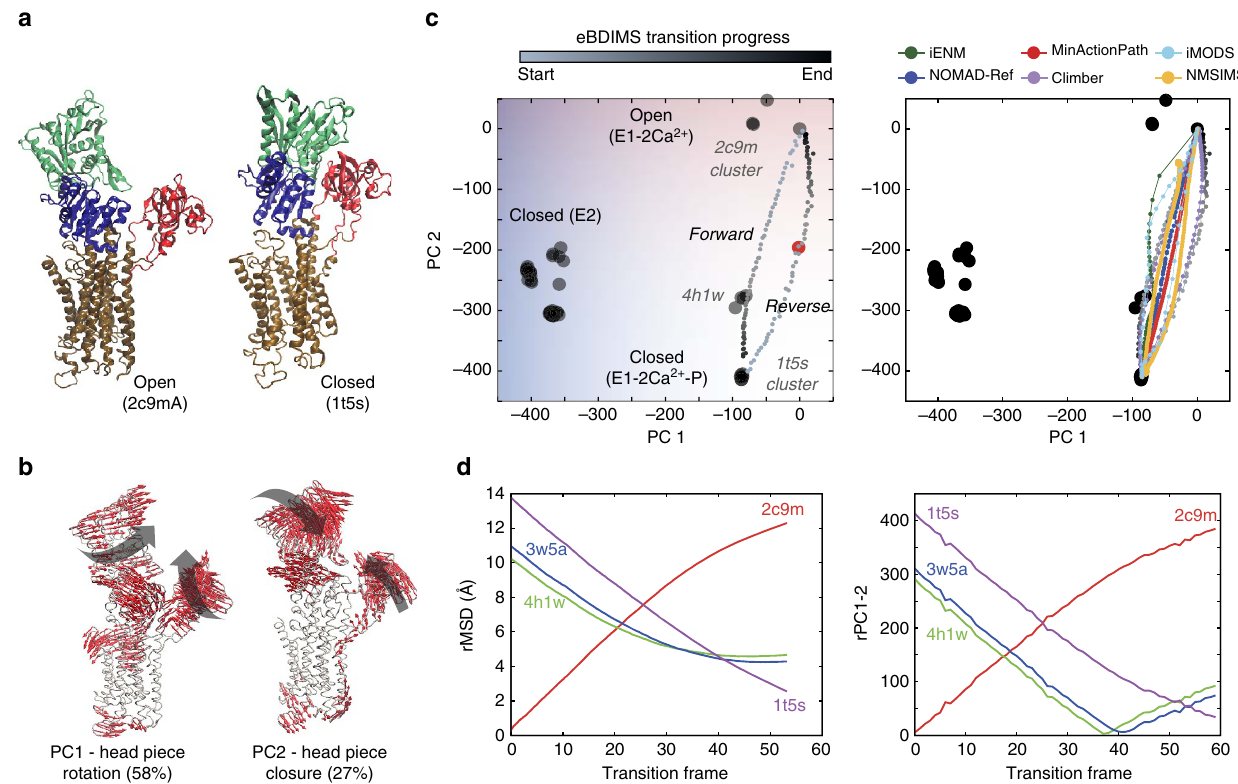
Figure 5 | Conformational transition of O. cuniculus sarcoplasmic Ca 2 þ -pump (SERCA). ( a ) Crystallographic E1-Ca 2 þ bound open (2c9m) and E1-Ca 2 þ - nucleotide bound (1t5s) state, showing the headpiece domains coloured in red (A), blue (P) and green (N) and the TM helices in brown. ( b ) Principal components of the X-ray ensemble (65 structures) describe the E2- 4 E1 pumping transition (PC1) and the closing of the headpiece (PC2). ( c ) Left: projections of the X-ray ensemble structures and the eBDIMS trajectories onto the PC1-2 subspace; PC2 separates the crystal structures into open (red) and closed (blue); the reconstructed structure 4nab is shown as a red dot. Right: comparison between the forward pathways computed by eBDIMS, iENM, NOMAD-Ref, MinActionPath and Climber. Reverse pathways generated by eBDIMS, iMODS, NMSIM and Climber also shown. ( d ) rMSD and PC1-2 distance between the forward trajectory and two crystallographic